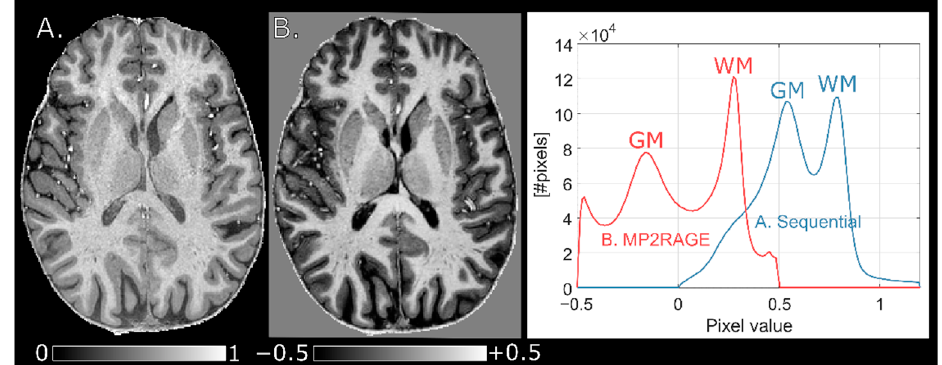
Figure 6. A normalized MPRAGE image ( A ) compared to an MP2RAGE image ( B ) with comparative whole-brain histograms. The MP2RAGE utilizes a larger dynamic range through the interleaved acquisition and complex combination and thus has a higher WM-GM contrast.